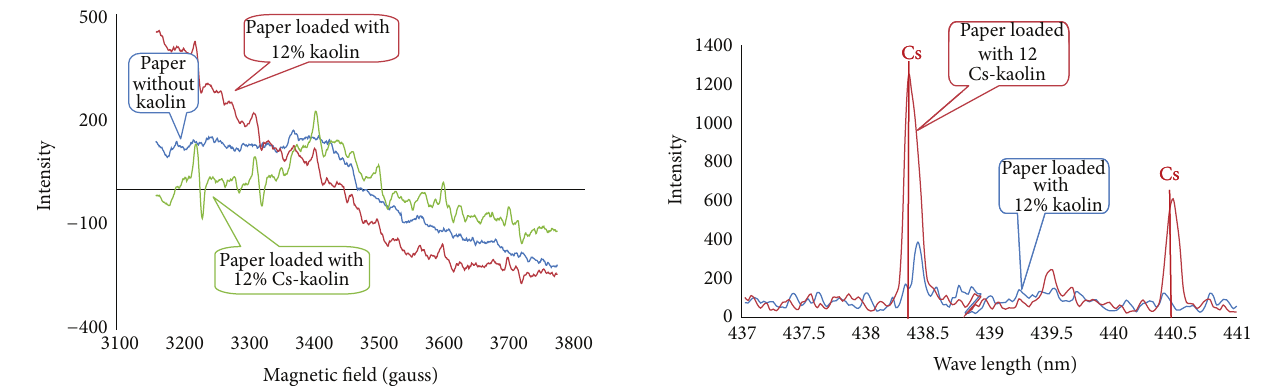
Figure 8: LIBS spectra for wood paper handsheets loaded by 12% kaolin and 12%